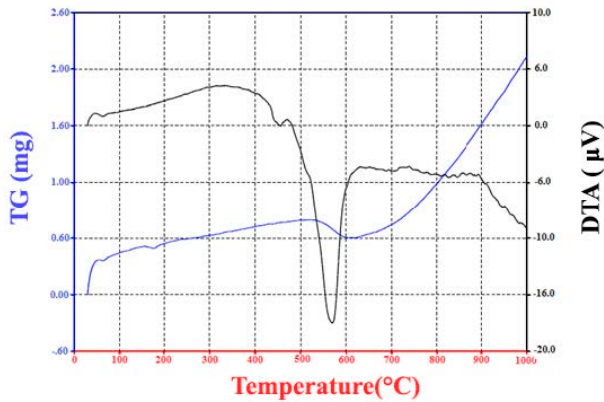
Figure 3. DTA (Differential Thermal Analysis) and TGA (Thermo Gravimetric Analysis) of TiH 2 powder.